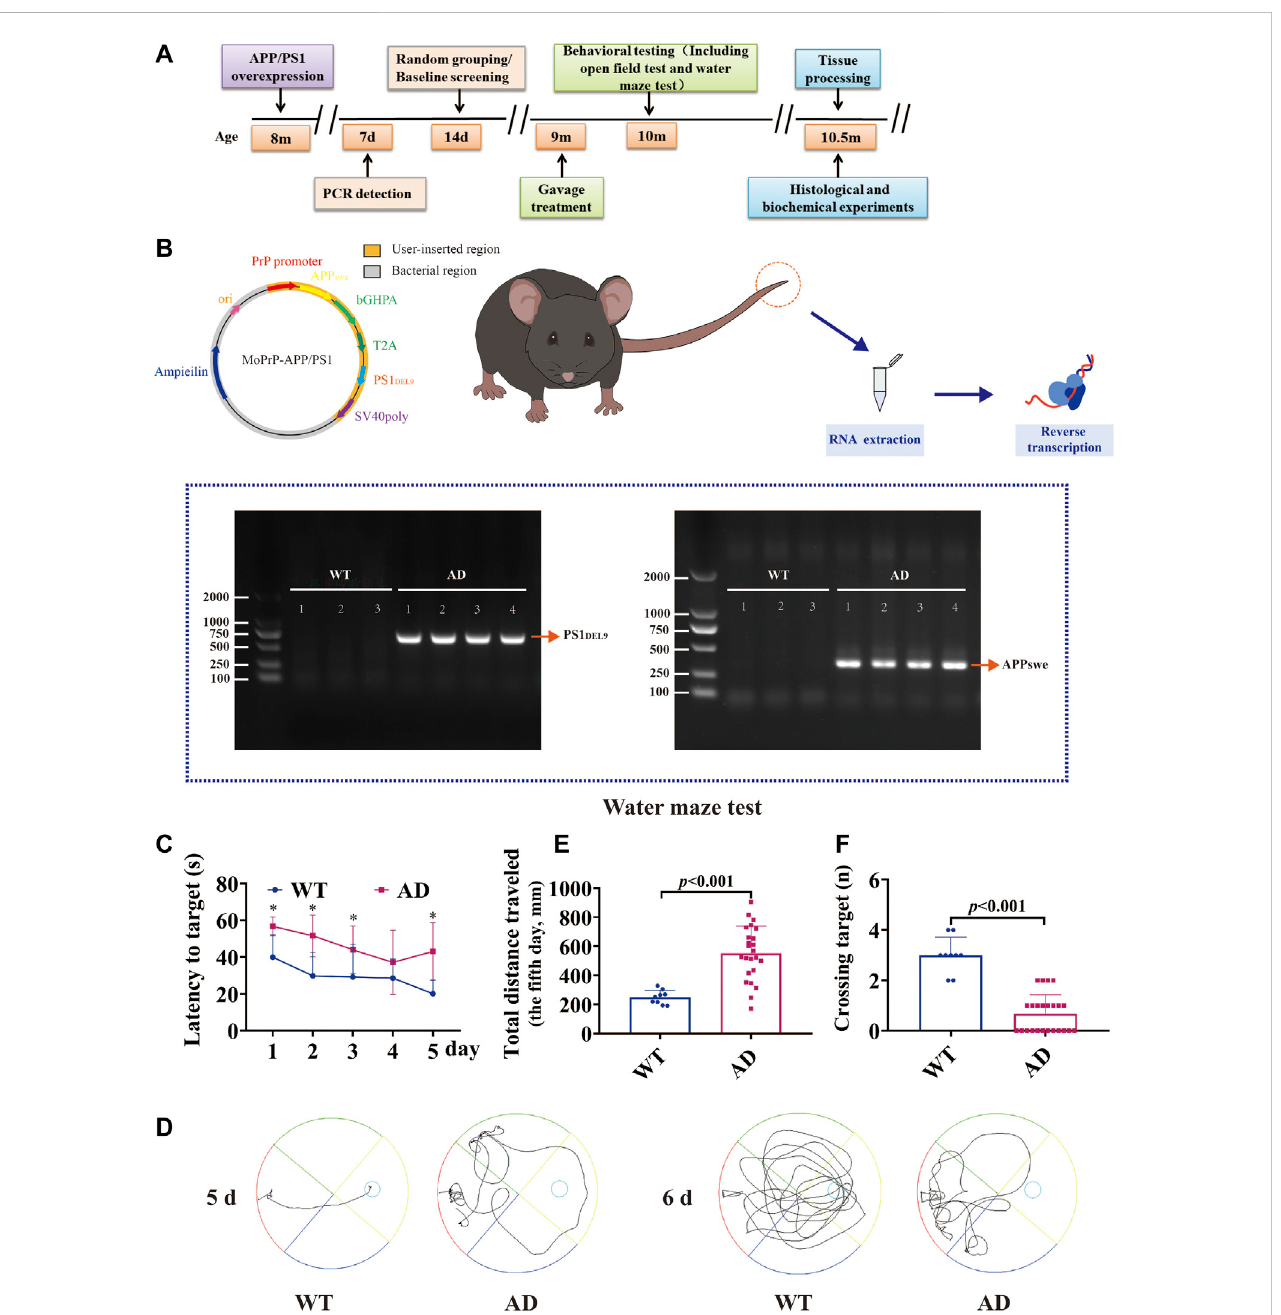
FIGURE 1 Experimental program and construction of AD transgenic mice. Mice were genotyped for tail detection and behavioral testing at 8 months of age, and gavage treatment was started at 9 months of age. Behavioral tests (including the open- fi eld test and water maze test) were performed at 10 months of age (1 month ofgavagetreatment), andmice wereexecuted forbiochemicalanalysis thedayafter behavioraltests werecompleted.TheexpressionofAPP/PS1 in thetail of mice was identi fi edusing PCR. A brightband was visible at350 bp and 608 bp compared to WT. APPswe/PS1DEL9 double transgenic AD mice weresuccessfullyconstructed. TheMorriswatermazetestsuggested that9-month-old ADmodelmice(APP/PS1overexpression)alreadyshowedsigni fi cant learning memory dysfunction compared to wild-type mice of the same age (data are presented as mean ± standard deviation) (WT, n = 9; AD, n = 24). (A) Experimental program. (B) Vector construction of APPswe and PS1DEL9 homologous recombination sequences and PCR detection of mouse genes. (C) Escapelatency(seconds)duringplatformtrials(*indicatesWTcomparedtotheADmodelgroup; p < .05). (D)